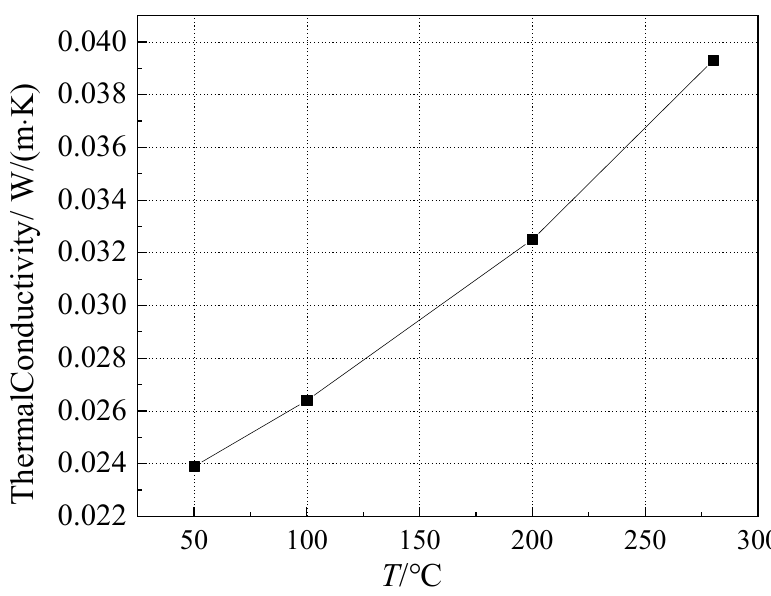
Figure 5. Thermal conductivity of extruded plastic panel samples at − 160 °C~30 °C.